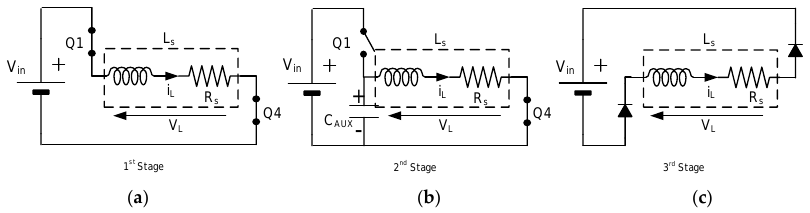
Figure 11. Full-bridge+buck converter stages: ( a ) First stage, ( b ) Second stage, ( c ) Third stage.